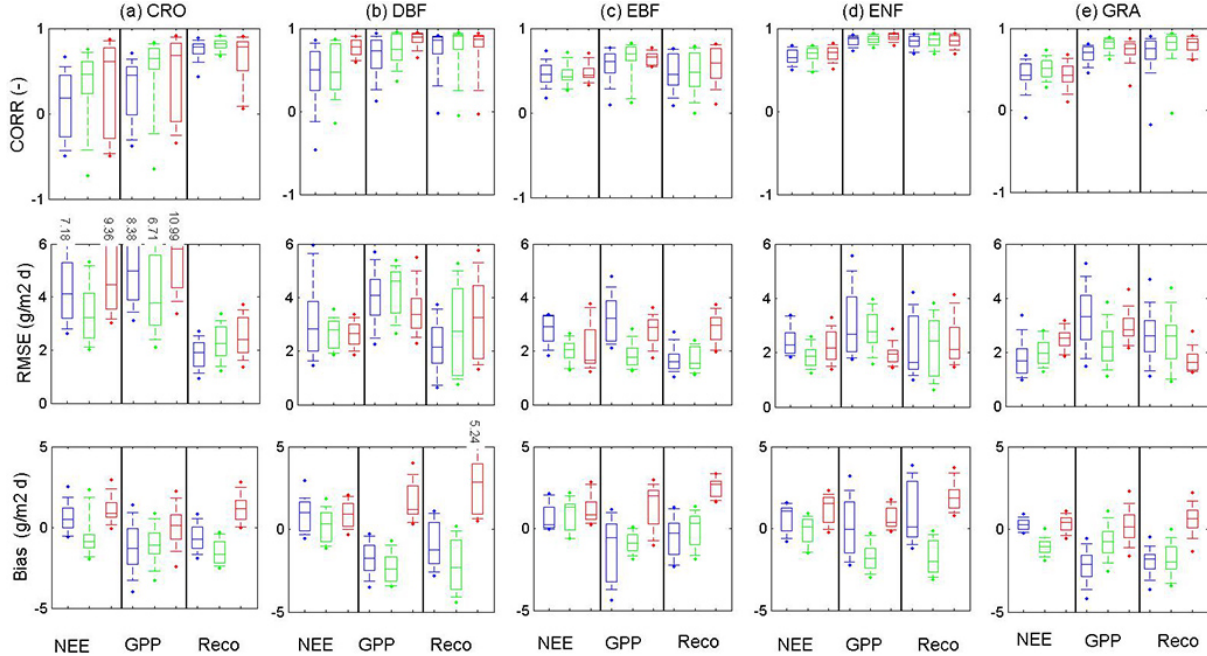
Figure 1. Performance of the simulations (ISBA-A-gs in blue, CTESSEL in green and ORCHIDEE in red) of daily carbon fluxes (NEE, GPP, and Reco) across PFTs on a site × year basis: (from top to bottom) annual CORR, RMSE, and bias scores – correlation coefficient, root mean square error, and bias, respectively. The tops and bottoms of each “box” are the 25th and 75th percentiles of the samples, respectively, and the distances between tops and bottoms are the interquartile ranges. The line in the middle of each box represents the median value. The whiskers are drawn from the ends of the interquartile ranges to the 25th and 75th percentiles. The highest/lowest annual outlier scores are displayed with a dot